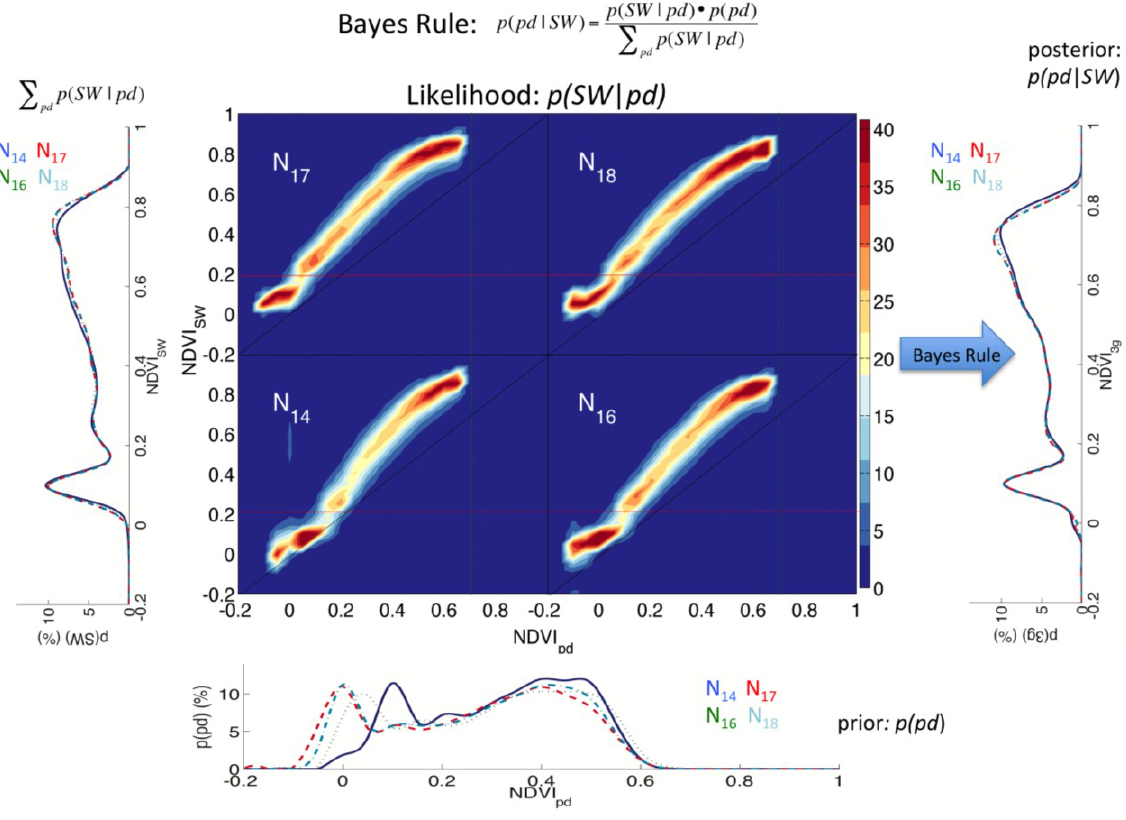
Figure 3. This diagram summarizes the Bayes’ rule process and the four different probability distribution functions when it is applied for each overlapping period between corresponding NDVI and NDVI values during 1998–1999 (NOAA-14), 2002–2003 SW pd (NOAA-16), 2004–2005 (NOAA-17), and 2007–2008 (NOAA-18). The middle panel shows the likelihoods or the actual probability distribution functions P(SW/pd) corresponding to each overlapping period. The shifting observed in the prior NDVI data (plots at bottom panel) are corrected in the computed posterior (plots at right panel). Notice the small population of anomalous values in the N panels with an NDVI value of zero that 14 pd corresponds to NDVI values between the range of 0.5 and 0.7. These values indicate that SW there are points in the AVHRR/2 record that were flagged as missing data. Users should note flag values to avoid mis-interpretations in their analysis (see Appendix B or README file provided with the data). Also notice the comparable dynamic range and degree of probability distribution functions between the evidence NDVI (plots at left sw panel) and the posterior AVHRR NDVI data. Concurrently mapped SeaWiFS NDVI data enabled these corrections to be made at the same time intervals and same spatial